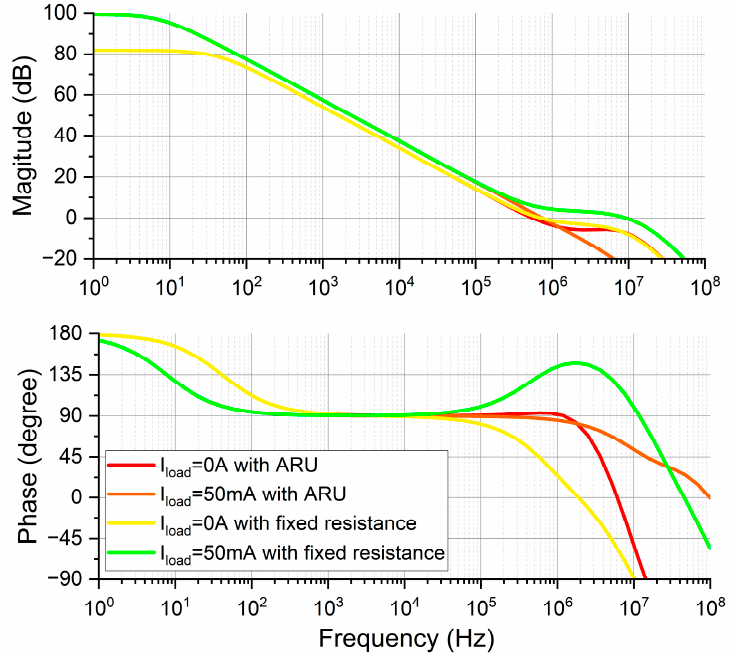
Figure 8. LDO loop gain and phase response with ARU and with fixed resistance.